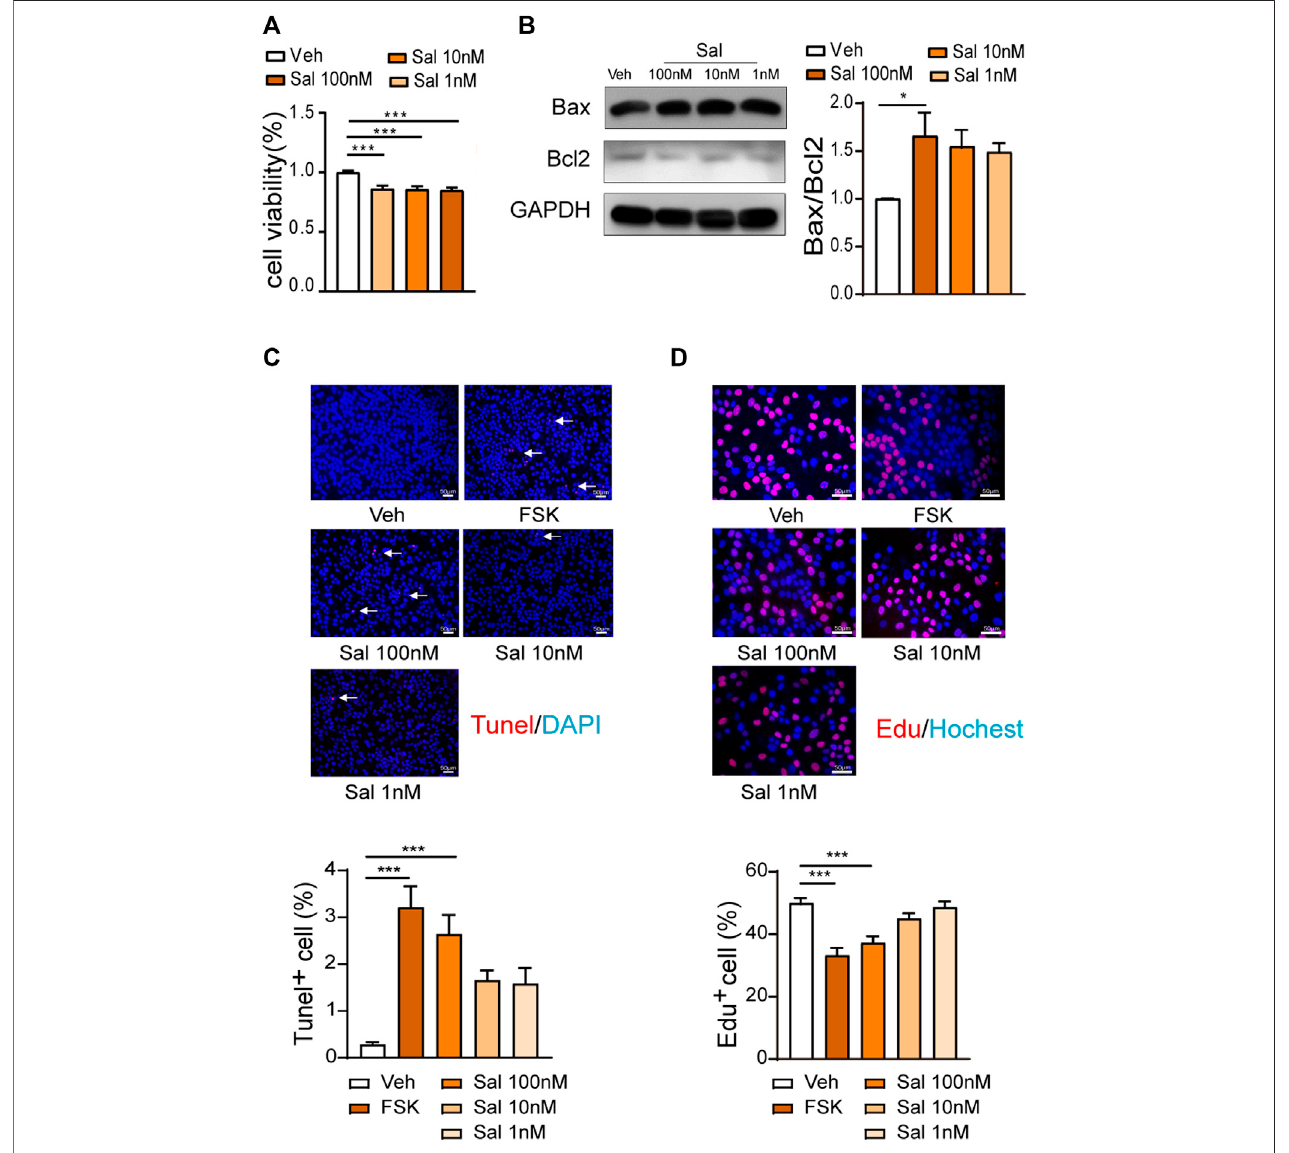
FIGURE2| EffectofSalmeteroloncellviability,cellproliferationandapoptosis. (A,B) HaCaTcellswereculturedinDMEMcontaining10%FBSandtreatedwithSal at the indicated concentration for 48 h. (A) Cell viability was measured by a CCK8 assay ( n = 3). (B) Western blotting analyses of the Bax/Bcl2 ratio ( n = 4). (C,D) HaCaTcellswereculturedinDMEMcontaining10%FBSandthentreatedwithSalattheindicatedconcentrationsorFSK(10 μ M)for48 h( n =3). (C) Cellapoptosiswas measured by a TUNEL assay (×200, Scale bar = 50 μ m). (D) Cell proliferation was measured by EdU incorporation (×400, Scale bar = 50 μ m). Data are presented as the mean ± SEM. * p < 0.05 and *** p < 0.001 by one-way ANOVA followed by Tukey ’ s post-hoc test.